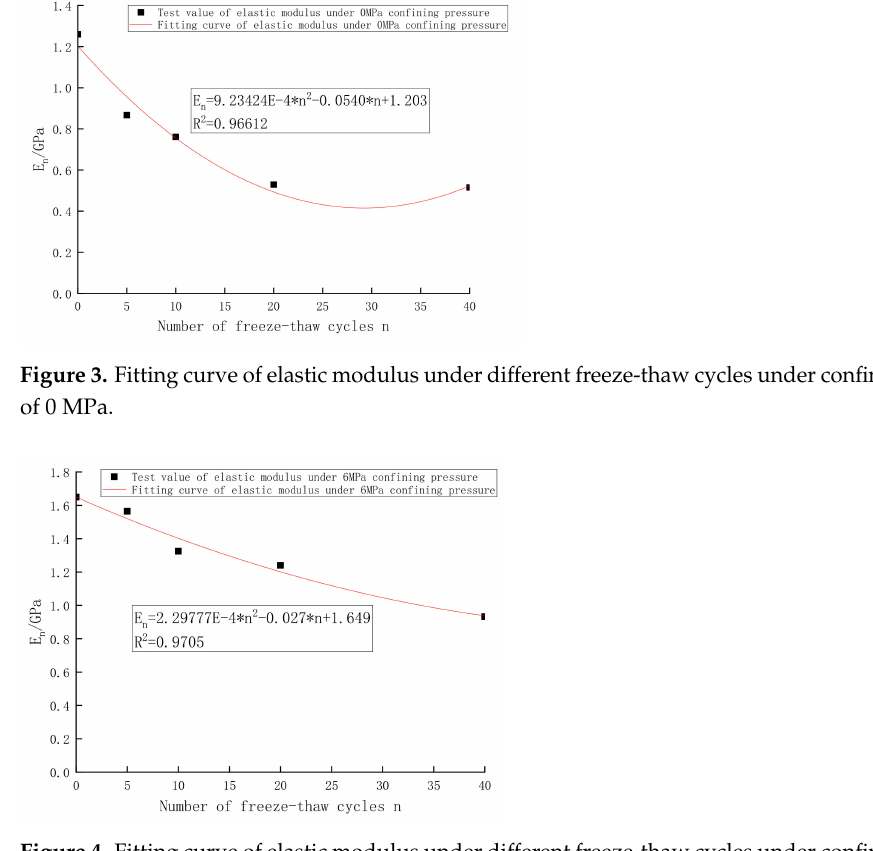
Figure 4. Fitting curve of elastic modulus under different freeze-thaw cycles under confining pressure of 6